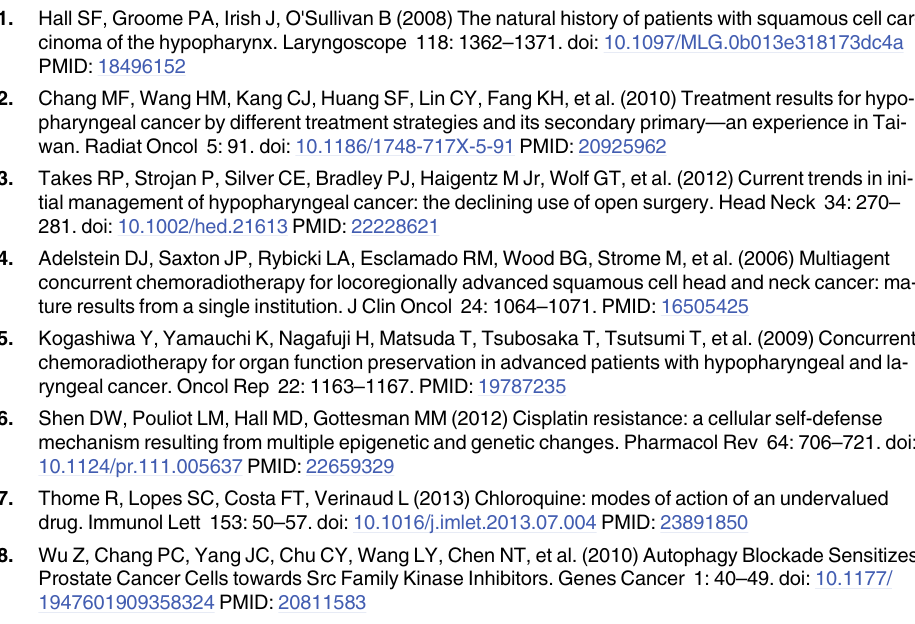
S1 Fig. Flow charts for scheduling of the drugs. CQ (60mg/kg/day) was administered intra- peritoneally (i.p.) for 18 consecutive days. DDP (5 mg/kg) was administered every 6 days. 3 in- jections were given in total. S2 Fig. LC3 II levels by densitometric analysis of the Western blot bands. (cid:1) p < 0.05, (cid:1)(cid:1)(cid:1) p < 0.001. S1 Table. The Guidelines Checklist for Animal Research: Reporting In Vivo Experiments (ARRIVE). The Balb/c nude mice were used for the in vivo experiments, all the related infor- mation was